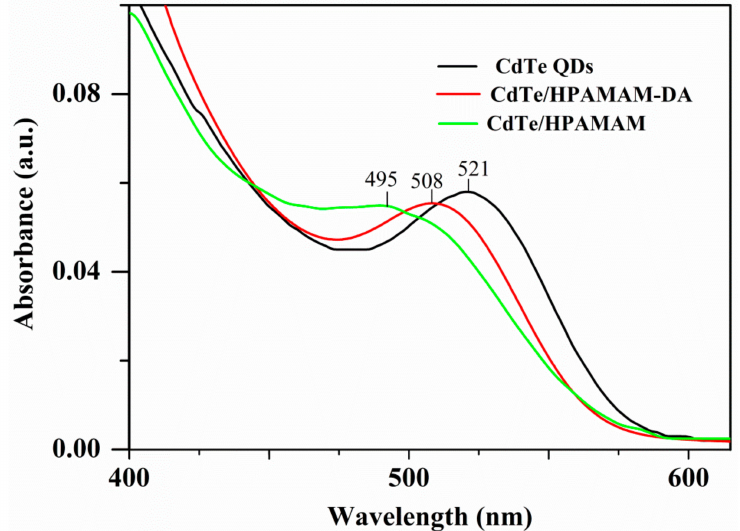
Figure 5. UV–Vis spectra of aqueous CdTe QDs, CdTe QDs encapsulated by HPAMAM–DA in a